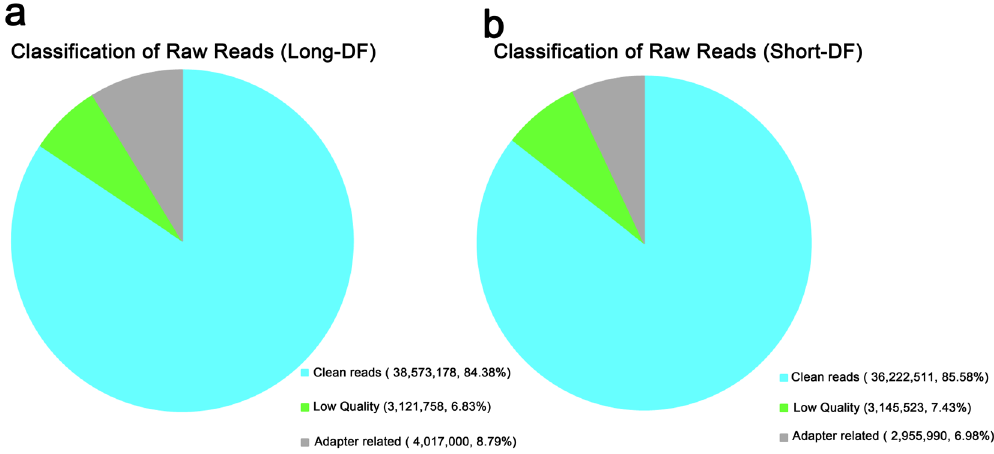
Figure 3. Classification of sequencing raw reads from ( a ) Long-DF and ( b ) Short-DF libraries in hens.